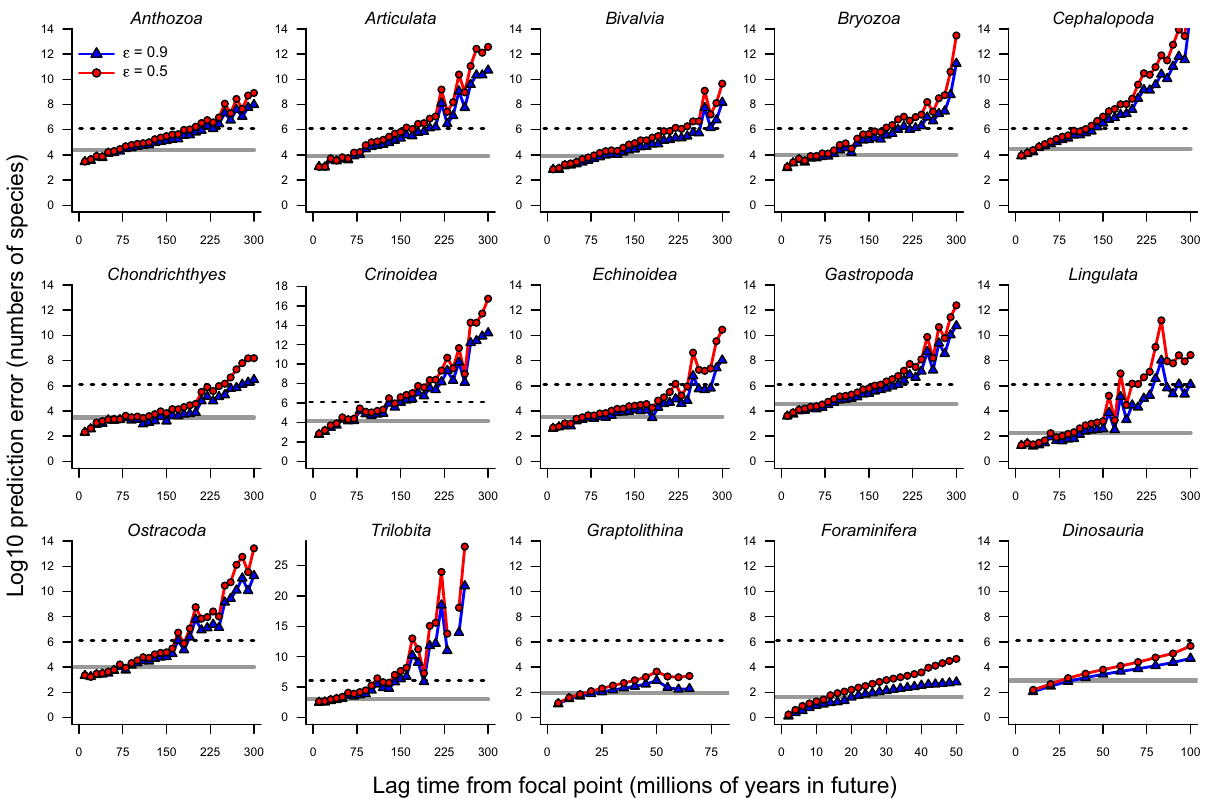
Fig. 3 Predictive accuracy of ARR estimates of net diversi fi cation rate. Forward-time prediction error (positive lag) for species richness under ARR rate estimates ( ε = 0.5: red circles; ε = 0.9: blue triangles) for paleontological diversity-through-time series. Solid gray line denotes maximum richness observed for each clade; dotted line is number of described species on Earth. ARR prediction errors increase rapidly as a function of lag time, even for clades that appear to be undergoing rapid increases in diversity through time (e.g., Bivalvia, Gastropoda, Dinosauria; Supplementary Fig. 1). Points show median absolute prediction error in species richness for all pairs of timepoints that fall within a particular lag bin (e.g., + 15 to + 30 my). ARR estimates of net diversi fi cation rate have virtually no ability to predict future diversity for any paleontological time